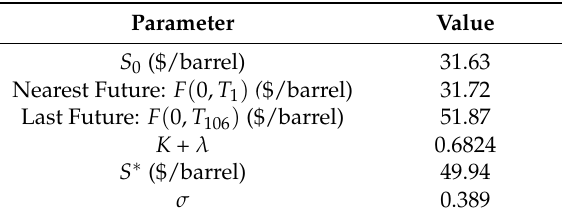
Table A1. Parameter Values 2 April